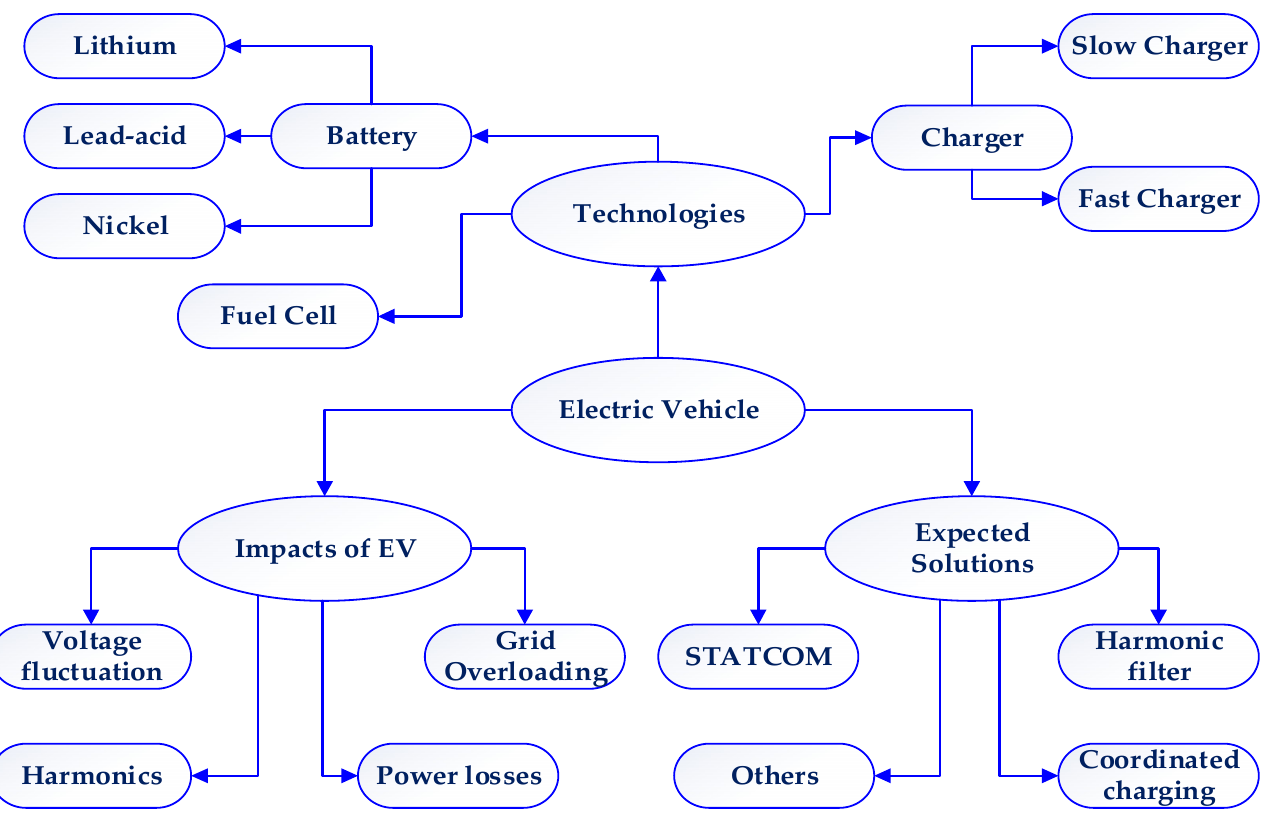
Figure 2. Different aspects of electric vehicles (EVs).